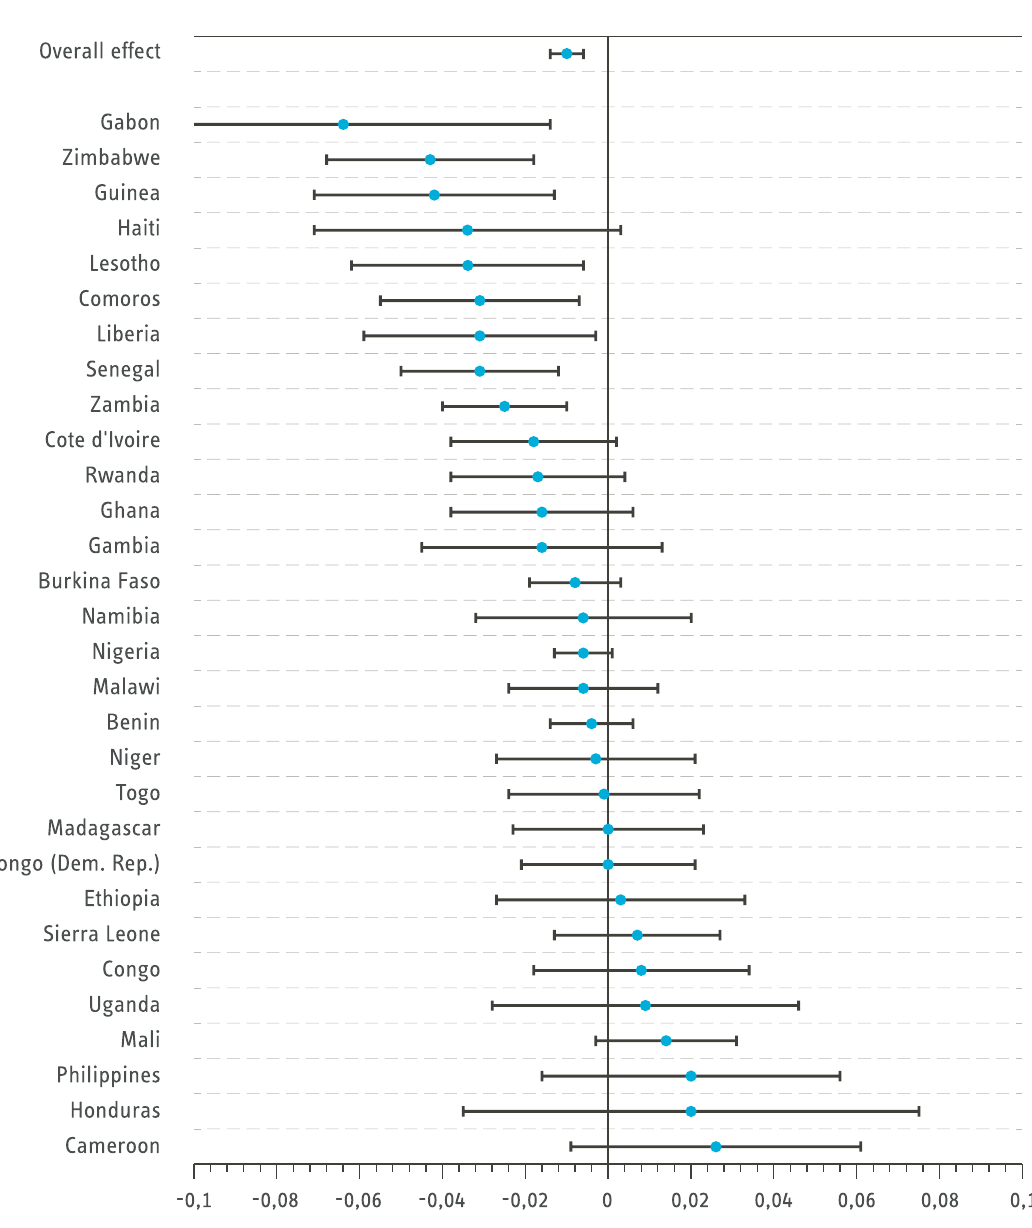
Fig 2. Effect size of outdoor cooking on ARI for children aged 0-1 (Probit estimation with controls). Bars signal 95 percent confidenceintervals. Standarderrors are clusteredon household level. Congorefers to the Republicof Congo and Congo(Dem. Rep) refers to the Democratic Republicof the Congo. Source: DHS all country dataset from